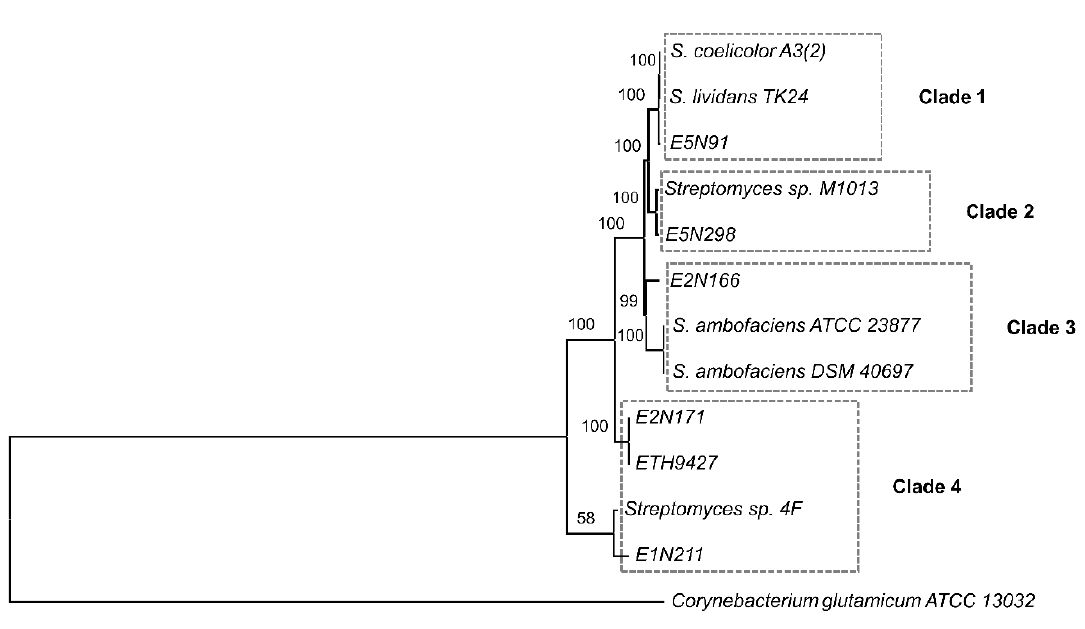
Figure 1. Phylogenetic tree of sequenced isolated and reference strains. Constructed based on the concatenated sequence alignment of five loci ( atpB - gyrB - recA - rpoB - trpB ), using inference by neighbor-joining with 100 bootstrap replicates. Only positions with a minimum 92% site coverage were used and the final dataset has 9141 positions in total. The scale bar indicates 10% estimated sequence divergence. The tree is rooted on Corynebacterium glutamicum ATCC 13032.